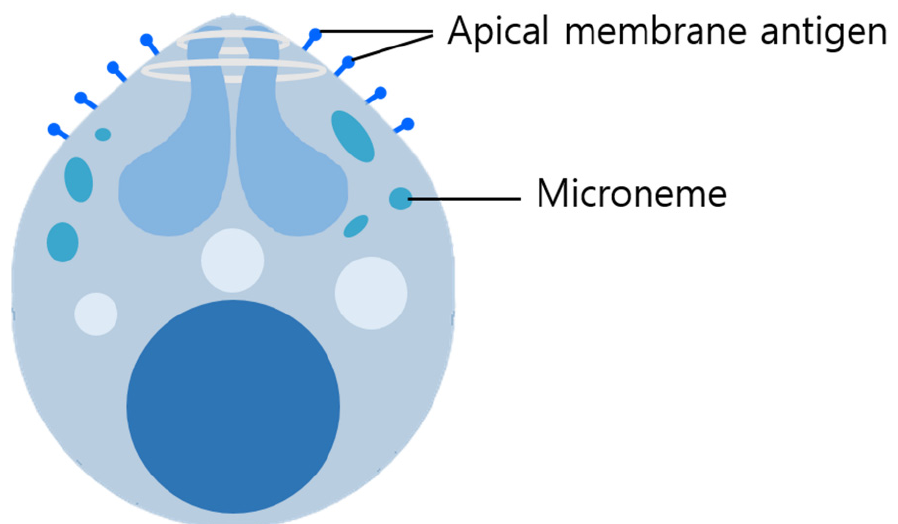
Figure A1. The diagram of the Plasmodium organism. The diagram describes the Plasmodium organism and the specified target gene (AMA1, MIC).